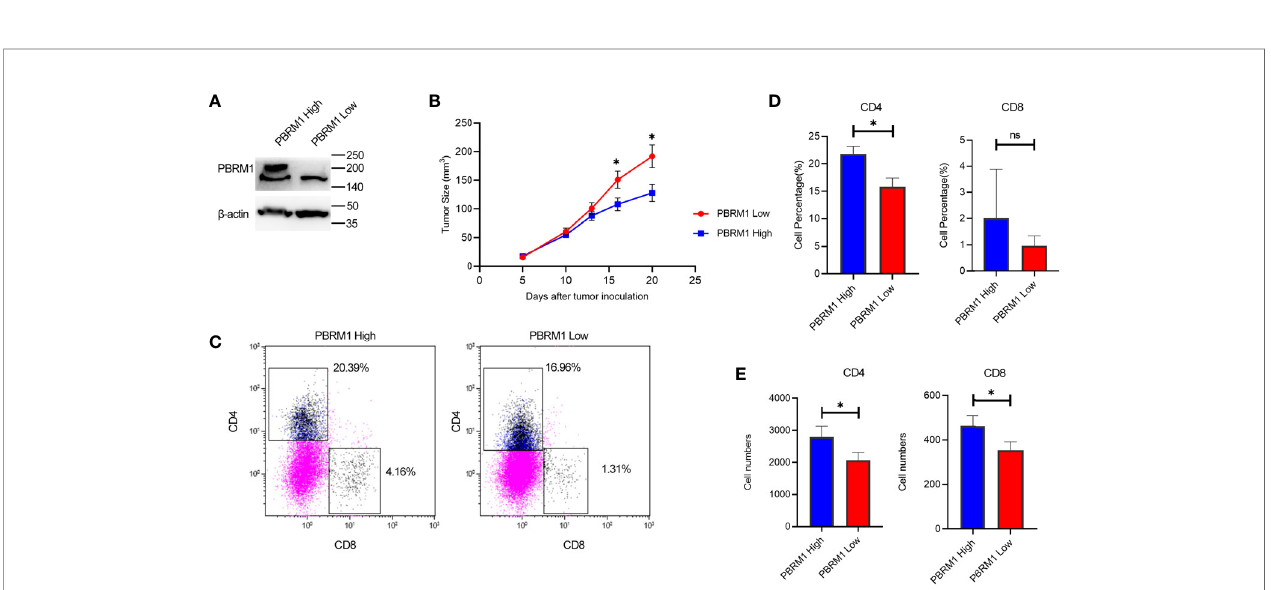
FIGURE 5 | Low expression of PBRM1 causes reduction of tumor-in fi ltrating CD4 cells in ccRCC mouse model. (A) PBRM1 protein expression level in PBRM1 high and PBRM1 low Renca cells were detected by western blot. PBRM1 low Renca cells were obtained using shRNA to PBRM1. b -actin was used as an internal control. (B) Growth curves of PBRM1 High and PBRM1 Low tumors in ccRCC mouse model. (C) Flow cytometry image of tumor-in fi ltrating T cells. TIL cells were isolated from tumors and gated CD45 + CD3 + cells. Percentage (D) and absolute numbers (E) of CD4 and CD8 cells in tumors of PBRM1 High and PBRM1 Low mice model. CD4 andCD8 cells gated in CD45 + CD3 + cells. Data represents 3 independent experiments at least 6 mice per group. *P < 0.05; ns, no signi fi